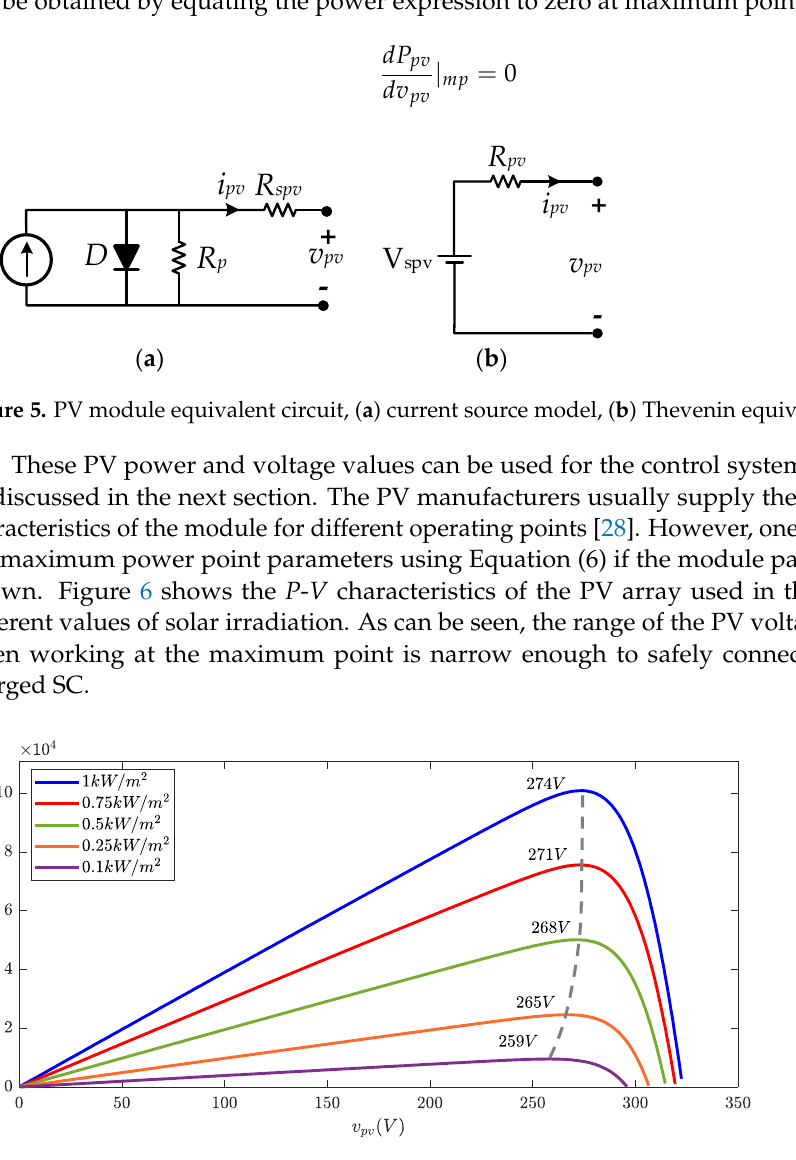
Figure 6. P - V characteristics of the PV array under the study, for different levels of irradiance and rated temperature ( 25 ℃ ).